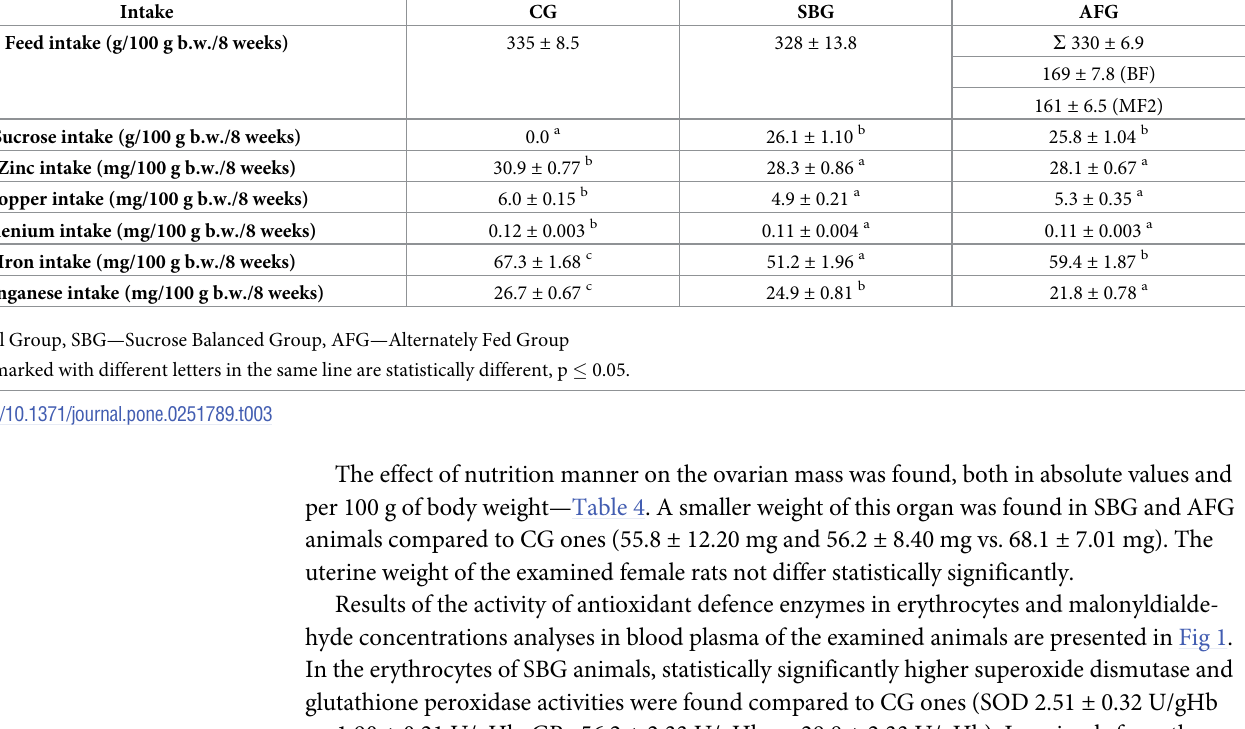
Table 3. Effect of sucrose content diet and alternating feeding on feed, sucrose, zinc, copper, selenium, iron and manganese intake in the examined rats. Intake Feed intake (g/100 g b.w./8 weeks)